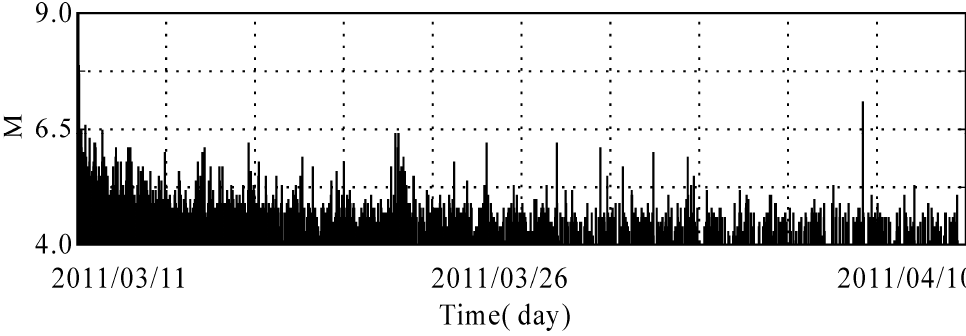
Figure 2. M–t plot of the Mw 9.0 earthquake sequence in Japan in 2011. Table 1. Number of earthquakes in different